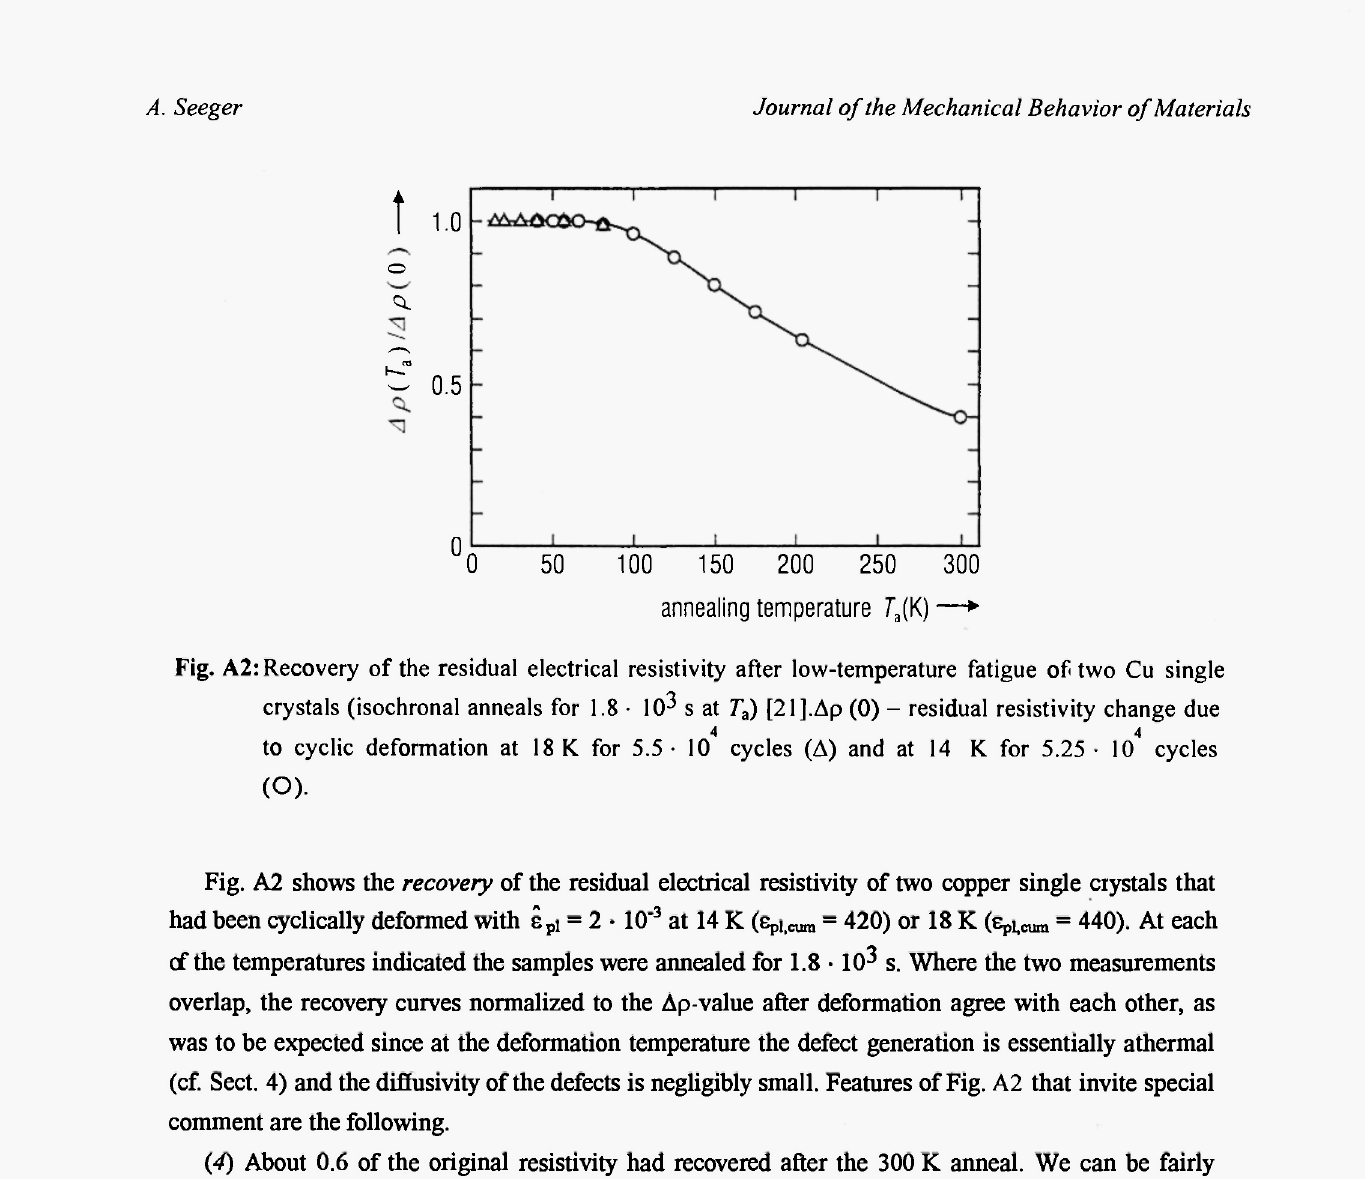
) [21].Δρ (0) - residual resistivity change due a 4 4